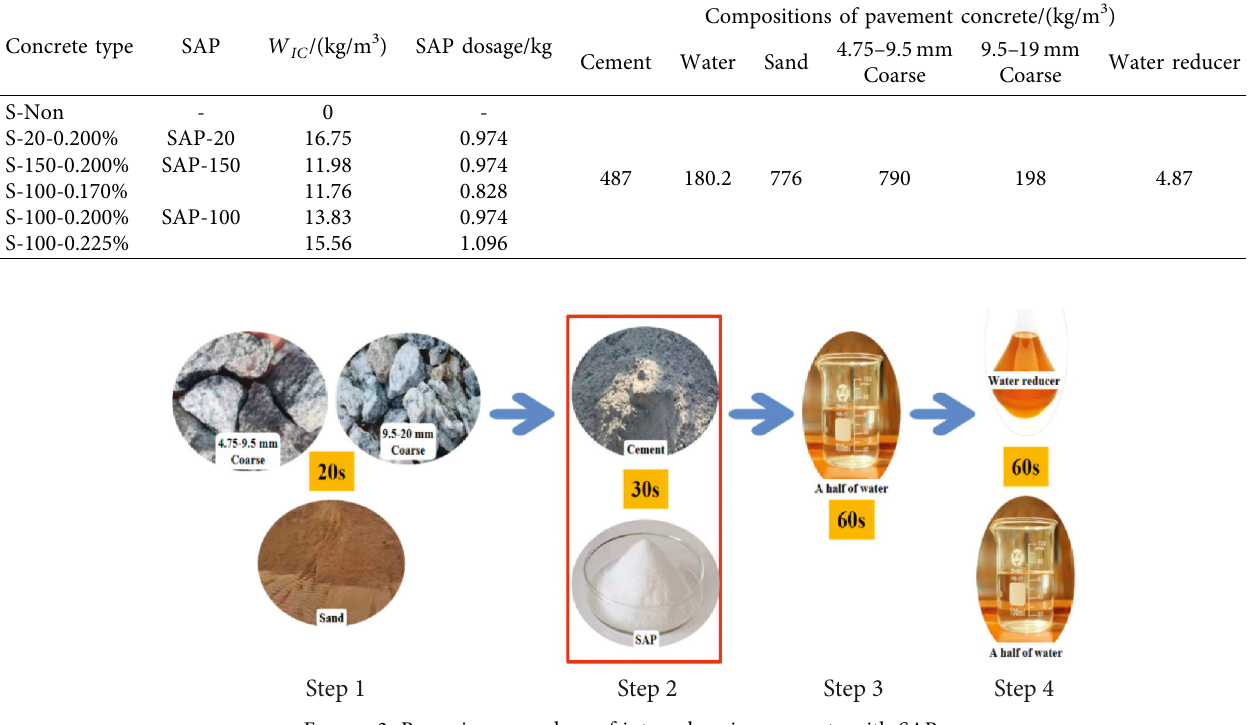
Table 3: Mix proportion of internal curing pavement concrete.